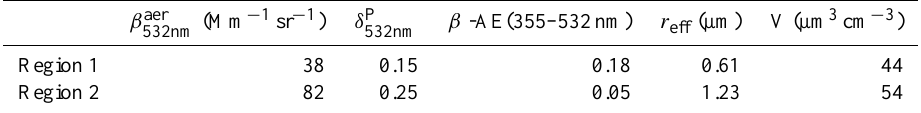
gions with different aerosol types were observed at night. Fig. 5d, r eff values varied in the different layers. The highest values, ∼ 1.76 µm, were found in the layer between 2500 and 3500 m a.s.l., which is the mineral dust layer. The